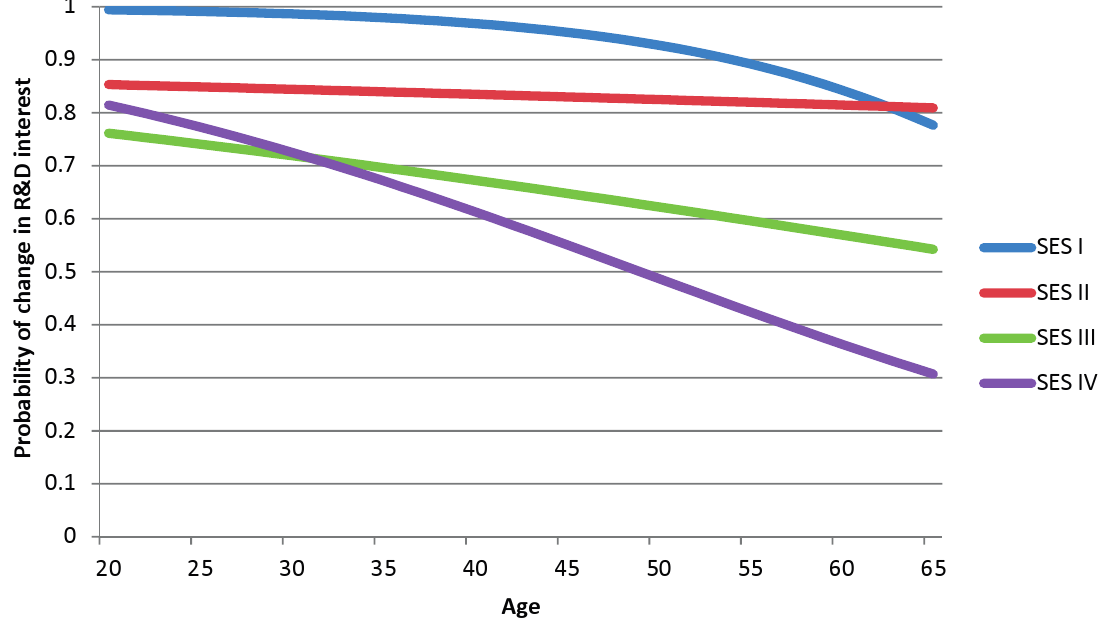
Figure 3. The probability of change in R&D interest as a function of